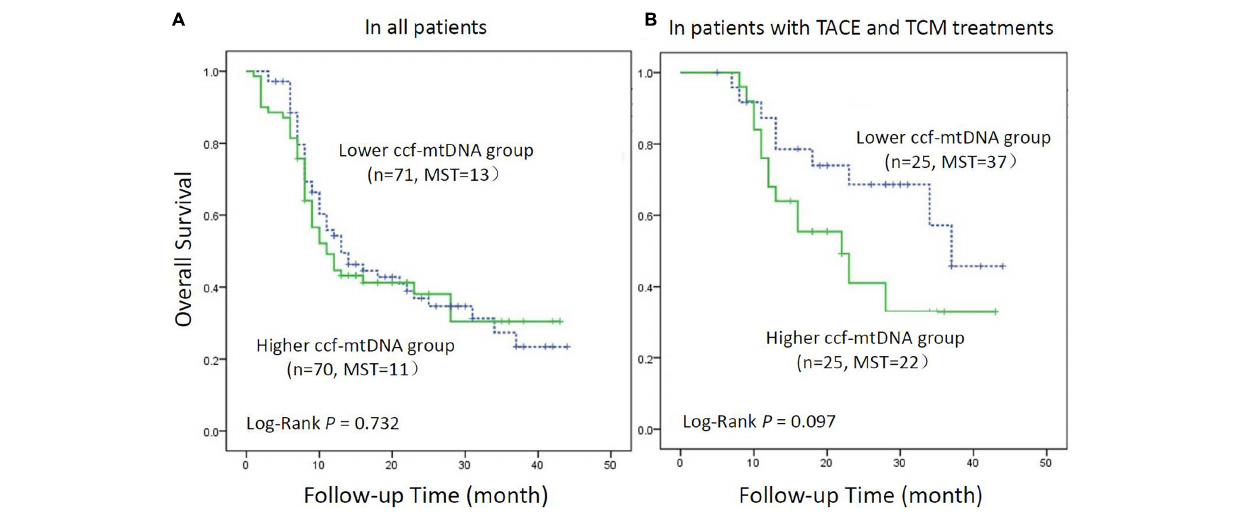
FIGURE 2 | Kaplan–Meier curve analysis of ccf-mtDNA content and hepatitis B virus-related hepatocellular carcinoma (HBV-HCC) patients. (A) All HBV-HCC patients ( n = 141). (B) HBV-HCC patients receiving transarterial chemoembolization combined with traditional Chinese medicine patients ( n = 50). MST indicates the median survival